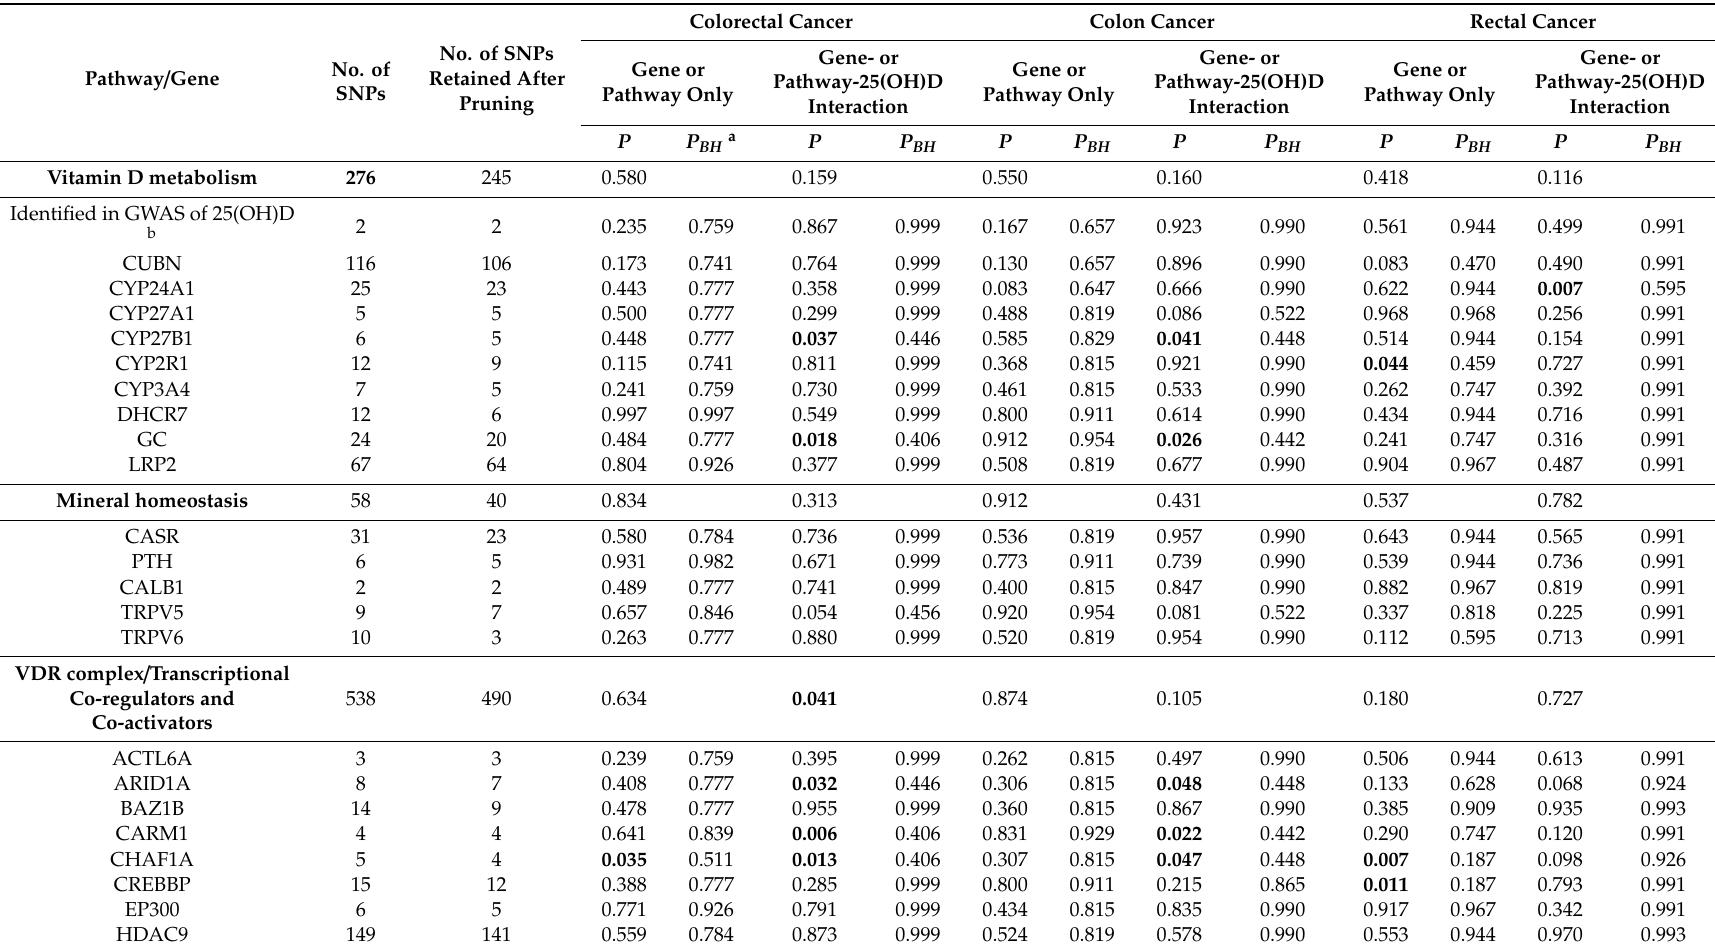
Table 4. P-values of pathway- and gene-level associations with CRC risk overall and by tumor location (colon vs. rectal) and of interactions with 25(OH)D concentrations (per 24.96 nmol / L), the EPIC study,